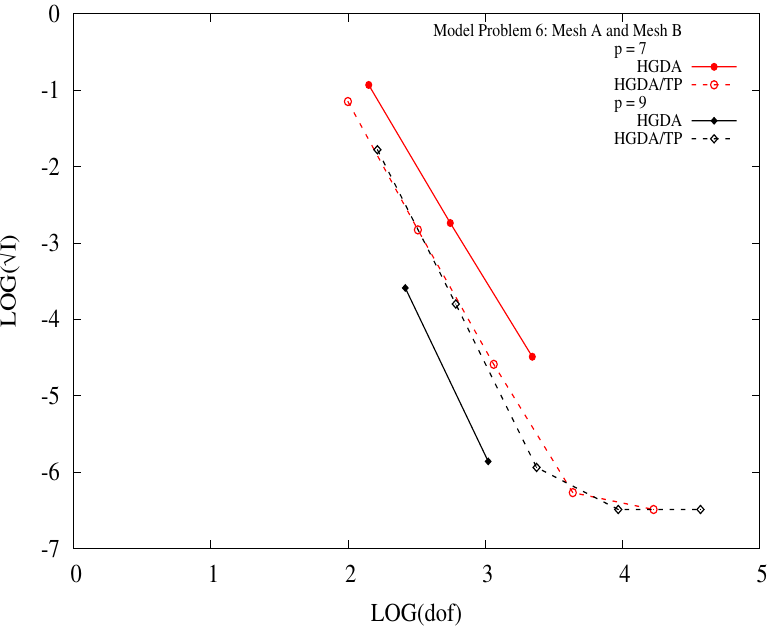
Figure 33. Residual function I versus dof, C 33 solutions: Model Problem 6 (Burgers Equation; Mesh B, HGDA/DG; Mesh A,